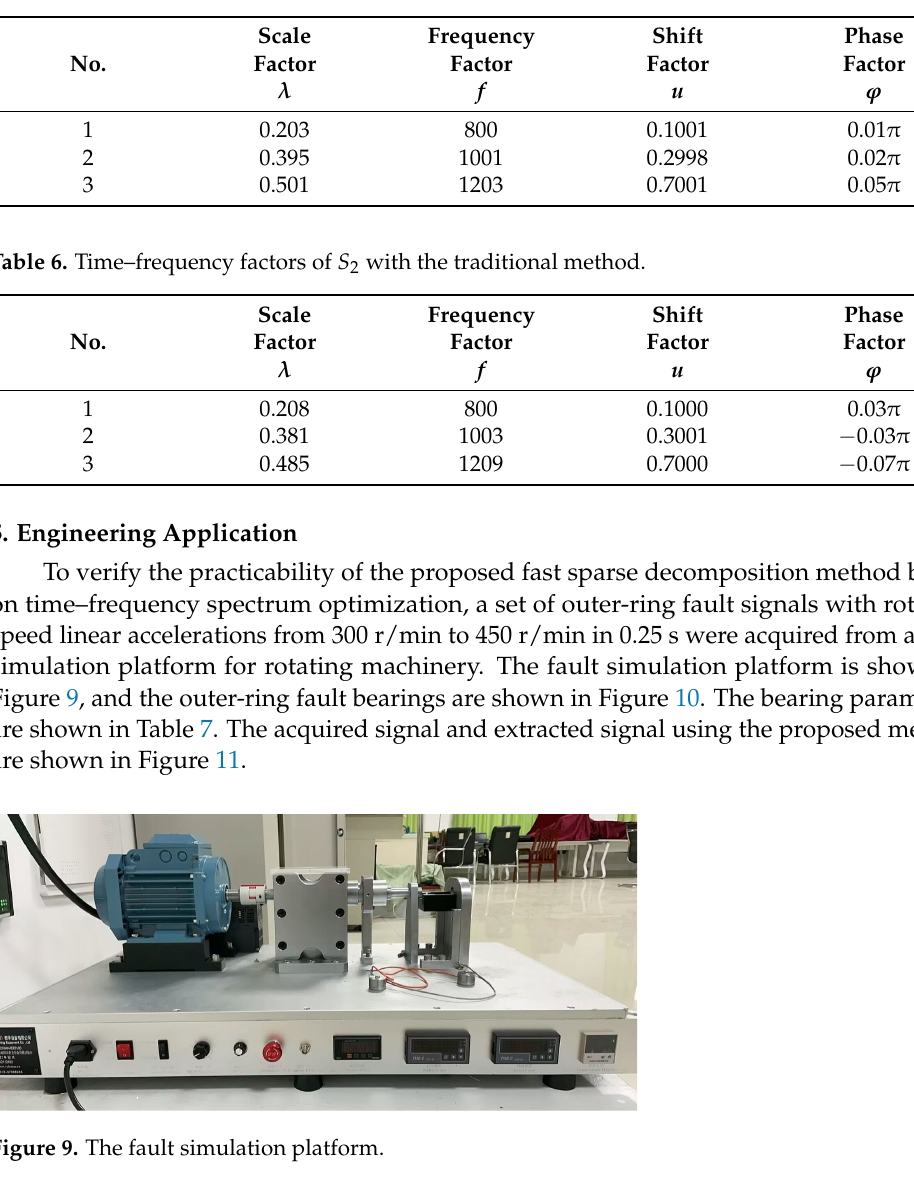
Table 5. Time–frequency factors of S 2 with the proposed method.